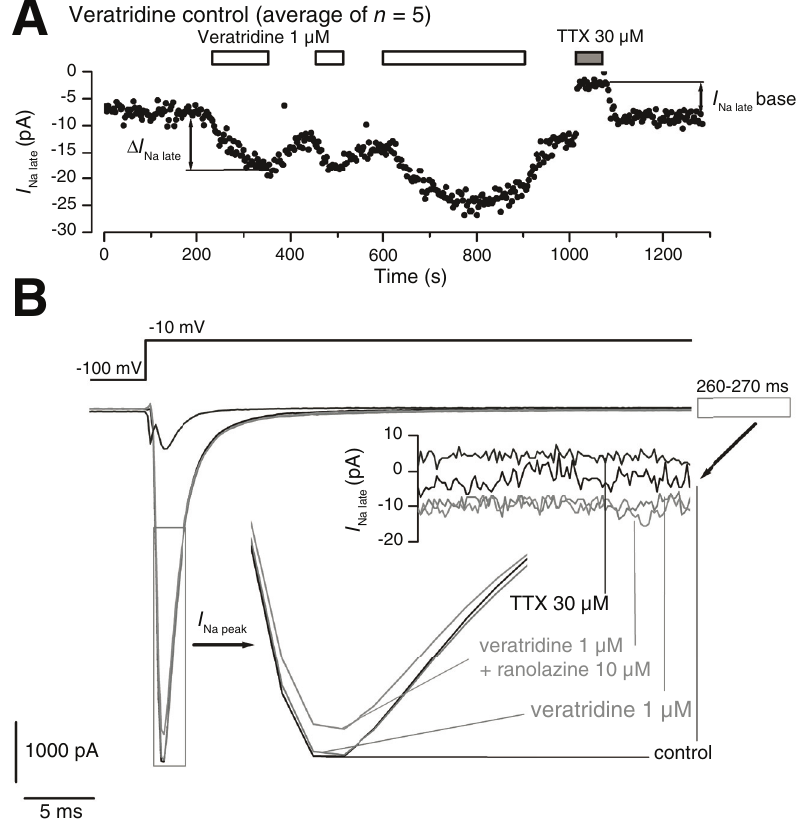
Figure 1. Activation by veratridine of the late Na + current in Nav1.5-expressing cells. A . Time course of I current during the last 100 ms of a 300-ms depolarizing pulse to -10 mV from a holding potential of -100 mV) during a typical experiment with repeated applications of veratridine 1 μM and a final application of TTX 30 μM. B . Overlap of individual sweeps showing the peak and late component of